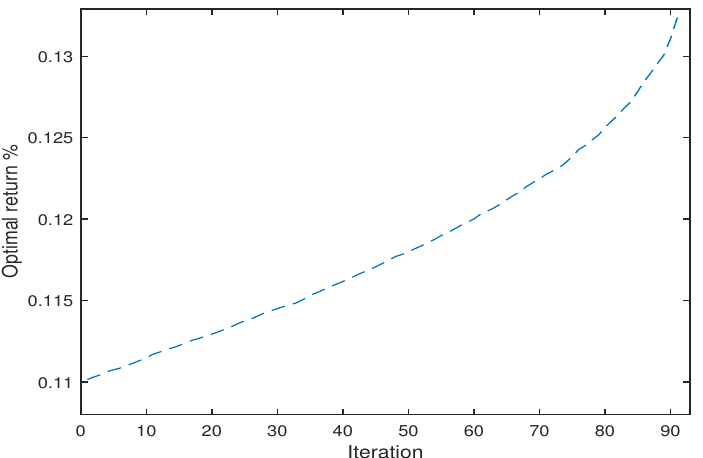
Figure 9. The specific asset structure of optimal portfolio in X ∈ [ − 0.05,0.15 ] of model (30) for 101 assets.